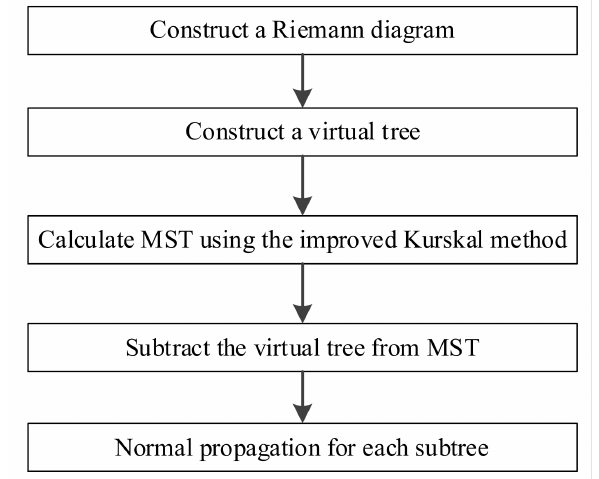
Figure 3. The improved minimum spanning tree